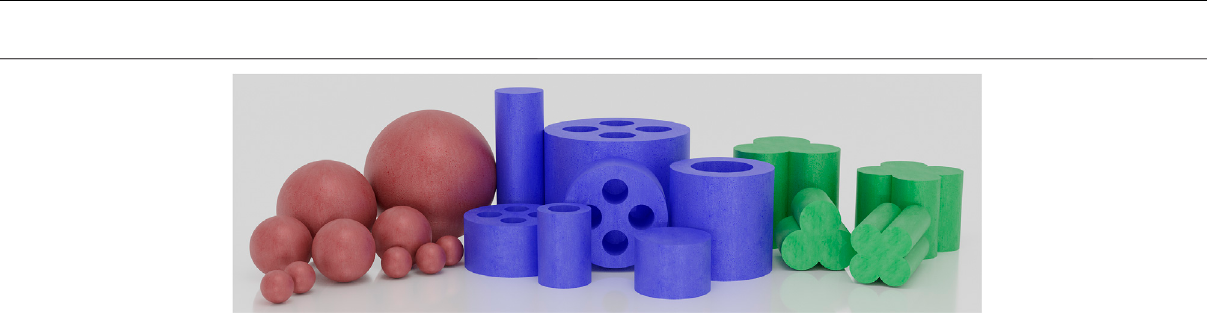
Frontiers in Chemical Engineering |